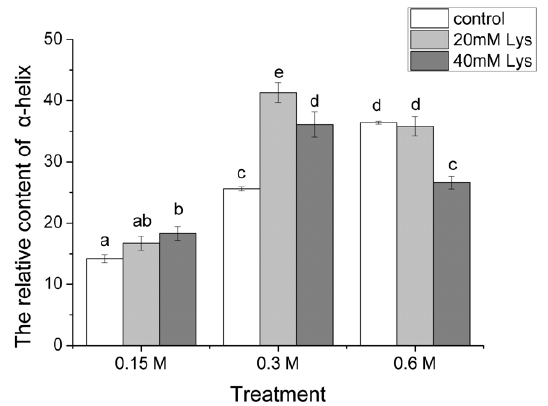
Figure 5. The effects of Lys on the relative content of α -helix in MFP solutions at different ionic strengths. Columns with different letters indicate significant differences at the level of p < 0.05. 0.15 M, treatment with ionic strength of 0.15 M NaCl; 0.3 M, treatment with ionic strength of 0.3 M NaCl; 0.6 M, treatment with ionic strength of 0.6 M NaCl; control, treatment without Lys addition; 20 mM Lys, treatment with 20 mM Lys; 40 mM Lys, treatment with 40 mM Lys.